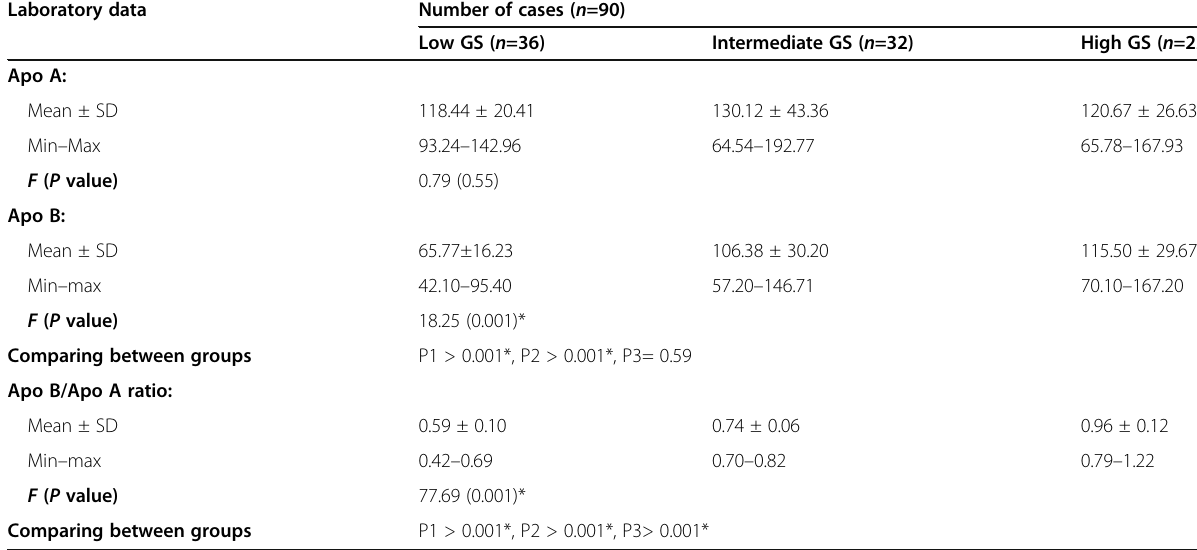
Table 5 Comparison between the studied patients as regard laboratory data Laboratory